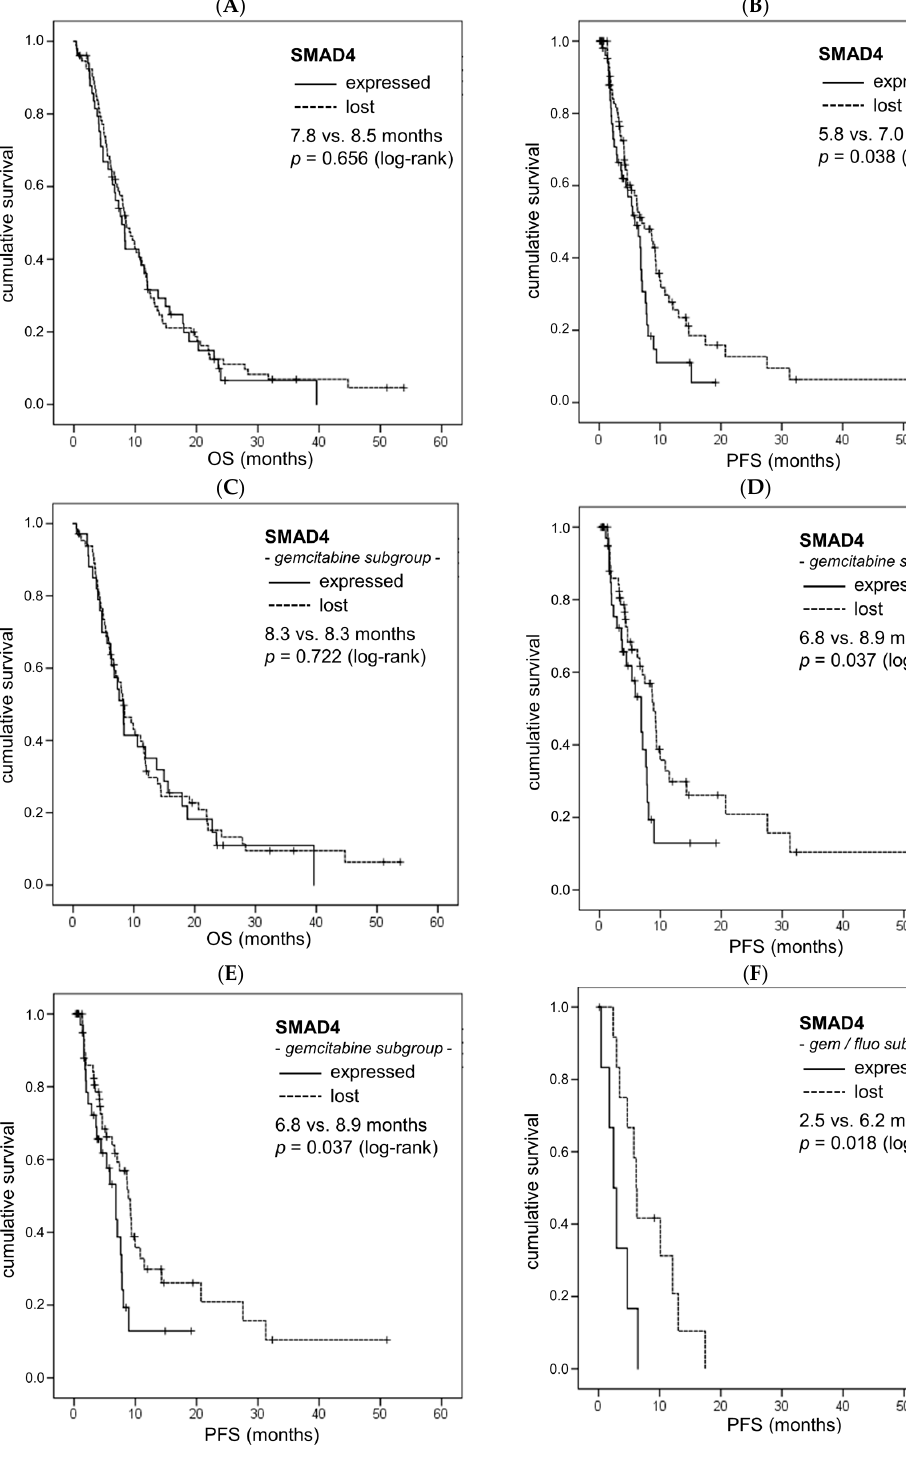
Figure 2. Loss of SMAD4 expression correlates with improved progression-free survival (PFS) but not overall survival (OS) in advanced PC (aPC), especially in gemcitabine-treated patients (pts). Univariate analysis (Kaplan–Meier curves and log-rank tests) of SMAD4 expression and OS as well as PFS in the total study population ( A , B ), the gemcitabine-based treatment subgroup ( C , D ) and the gemcitabine–fluoropyrimidine-based treatment subgroup ( E , F ) as a biomarker in the tumor tissue of palliatively-treated aPC pts. Crossed lines indicate censored cases.